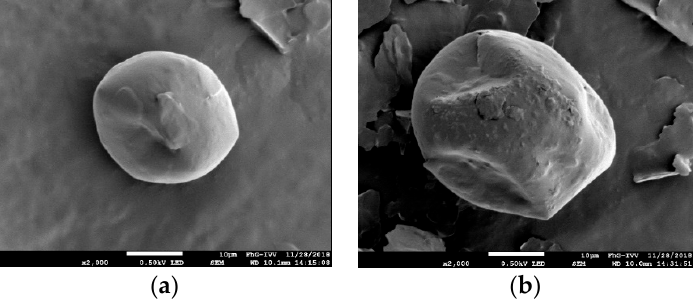
Figure 3. Exemplary scanning electron microscope (SEM) images from spherical and less spherical particles: ( a ) high spericity particle; ( b ) low sphericity particle.